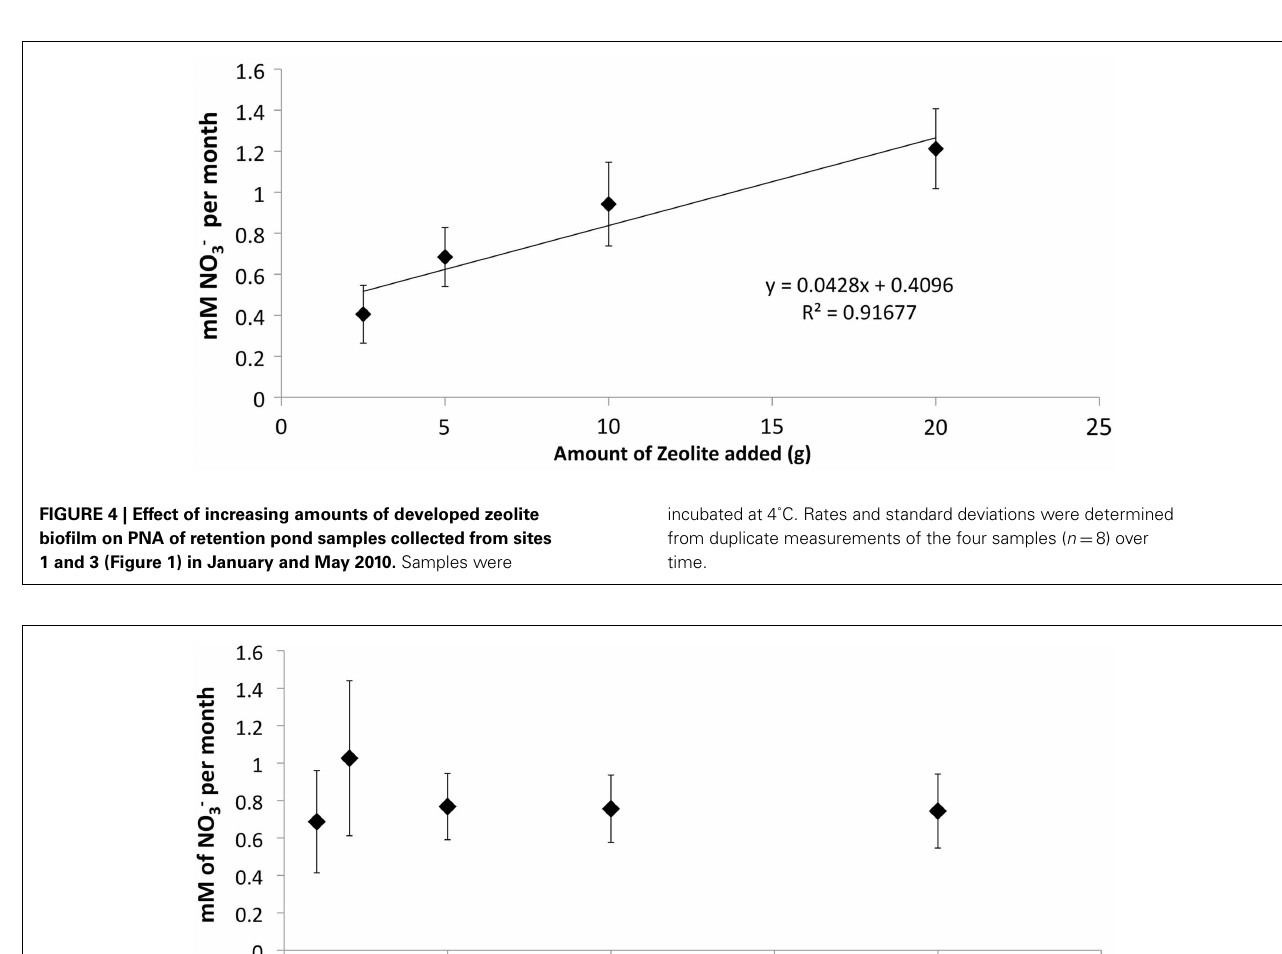
Samples were incubated at 4˚C. Rates and standard deviations were FIGURE 5 | Effect of increasing NH + concentrations on PNA in 4 determined from duplicate measurements of the two samples ( n = 4) retention pond samples collected from sites 1 and 3 (Figure 1) in over May 2010 and containing developed zeolite biofilm (0.1gmL − 1 ).